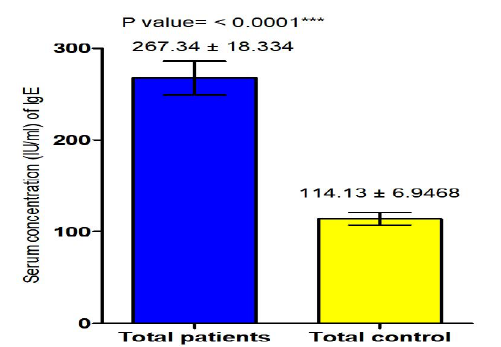
Fig. 3. Comparison between serum level of IgE in male and female with Sarcoptes scabiei and control group